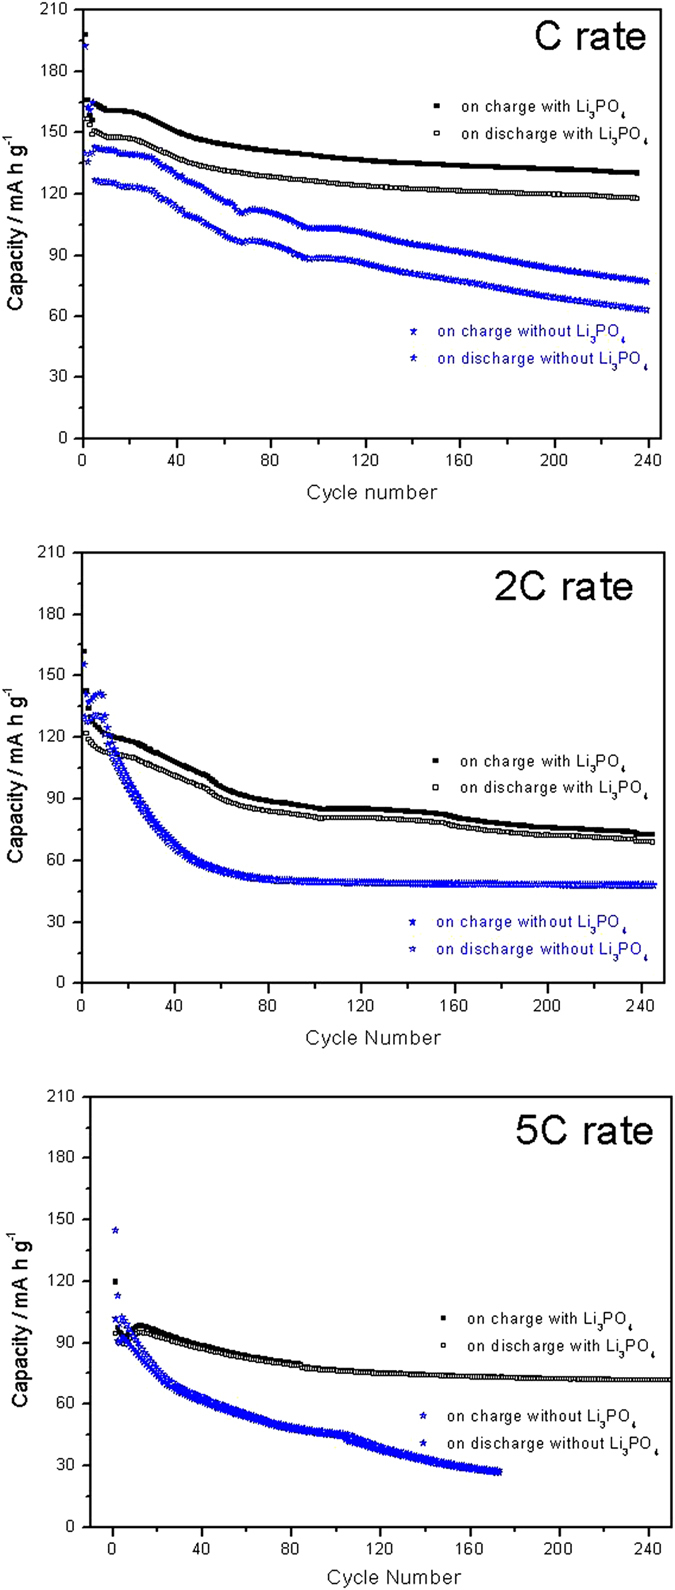
A comparison of specific capacity versus cycle number between nt-TiO2/Li2CoPO4F, and nt-TiO2/γ-Li3PO4/Li2CoPO4F cells, calculated at 1 C, 2 C, and 5 C rates.